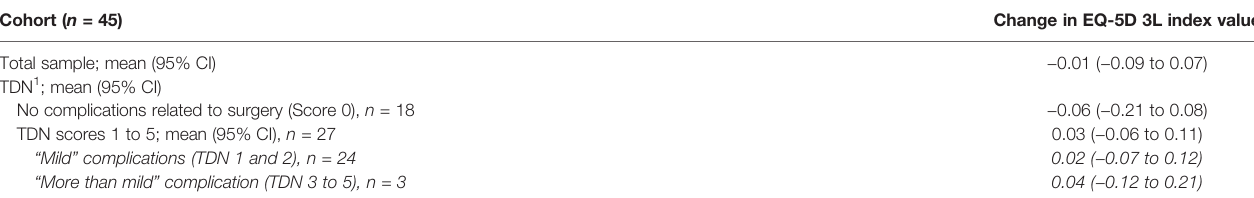
TABLE 5 | Change in the EQ-5D 3L index value in subgroups of patients based on TDN scores ( N = 45). Cohort ( n = 45)